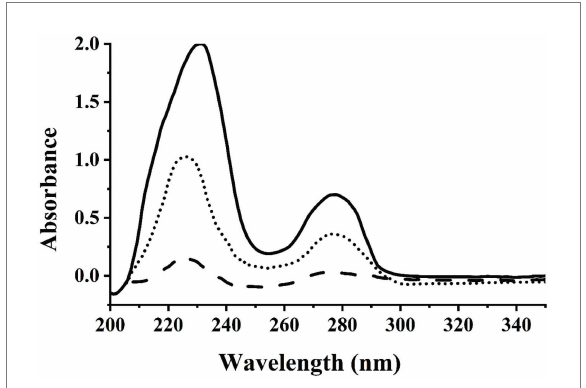
FIGURE 1 UV scanning detection of dicamba degradation by the enriched consortium. The sixth generation of the enriched consortium was inoculated into MSM supplemented with 500 mg/L of dicamba, which then was incubated in at 30 ° C and 180 rpm on a shaker. Solid line indicated the sample collected at 0 h, dotted line indicated the sample collected at 6 h, dashed line indicated the sample collected at 12